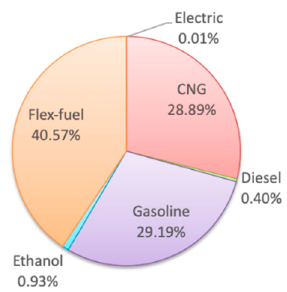
Figure 2. Light-duty passenger vehicles in Rio de Janeiro (RJ) state by engine technology—2016. Source: [28].